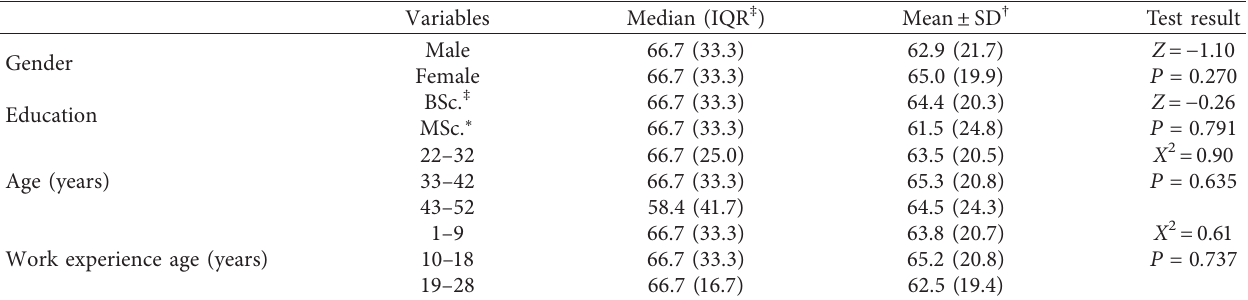
Table 4: Relationship between nurses’ attitude of toothbrush maintenance and use with demographic